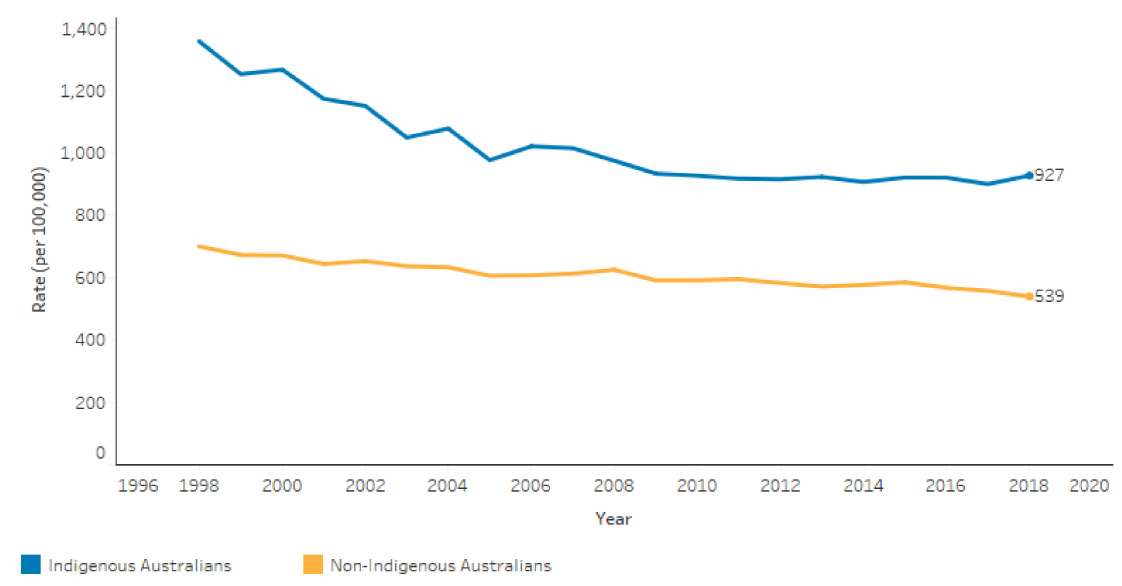
Figure 1. Age-standardized death rates, by Indigenous status, NSW, Qld, WA, SA, and NT, 1998–2018. Source: https: //www.indigenoushpf.gov.au/measures/1-22-all-causes-age-standardised-death-rates. (accessed on 16 August